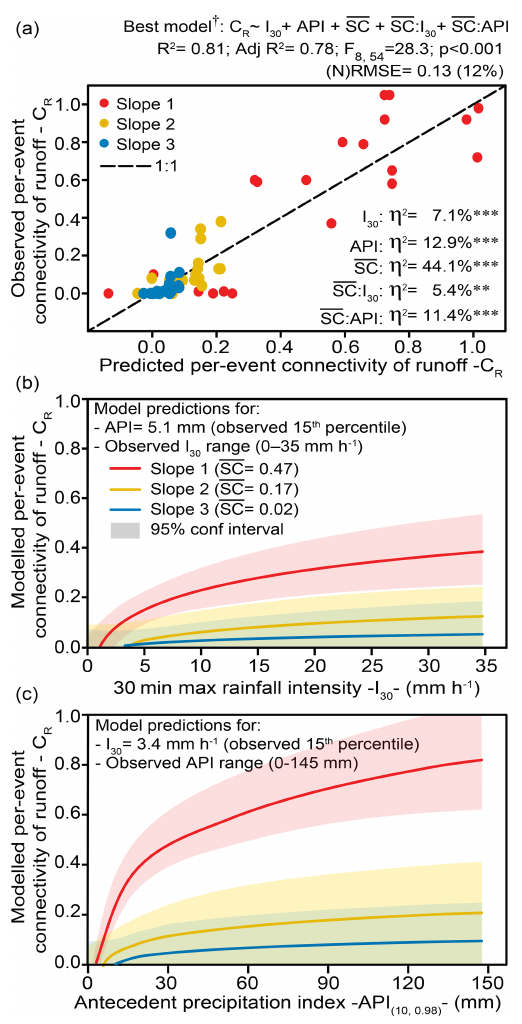
Figure 5. Structural and dynamic control of patch-scale to hillslope- scale runoff connectivity: (a) best-supported model of runoff con- nectivity and corresponding observed-versus-predicted runoff con- nectivity values; (b) modelled I 30 and SC effects on runoff con- nectivity (API is fixed at 5.1mm, 15th percentile of observed API values); (c) modelled API and SC effects on runoff connectivity ( I 30 is fixed at 3.4mmh − 1 , 15th percentile of observed values). The structure, R 2 , Adj R 2 , F statistic, p value and (normalized) root-mean-squared error of the best-supported model are detailed on top of the graph; η 2 values within the graph indicate the percent variance explained by the direct and interaction terms of the model. Significance: ∗∗∗ p < 0 . 001; ∗∗ p < 0 . 01; ∗ p < 0 . 05; “ns” not sig- nificant at α = 0 . 05. Note that † indicates that the model takes log- transformed values for the co-variables I 30 and API and that the graphs in panels (b) and (c) show back-transformed I 30 and API values for the modelled relationships.